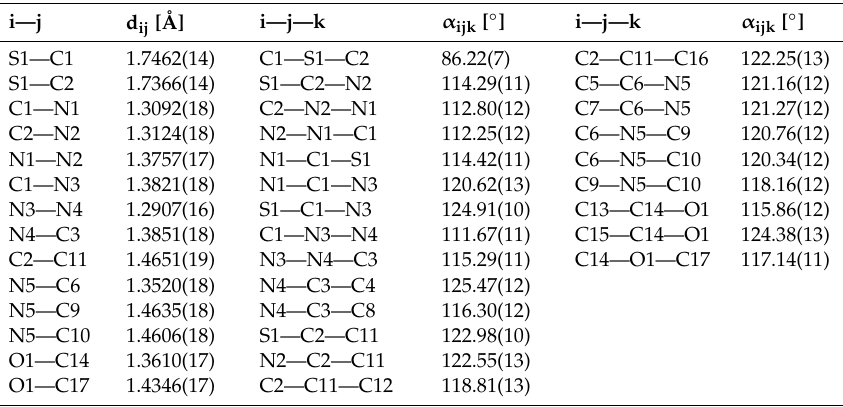
Table 2. Selected structural data of studied compound 5b Table 2 . Selected structural data of studied compound 5b .